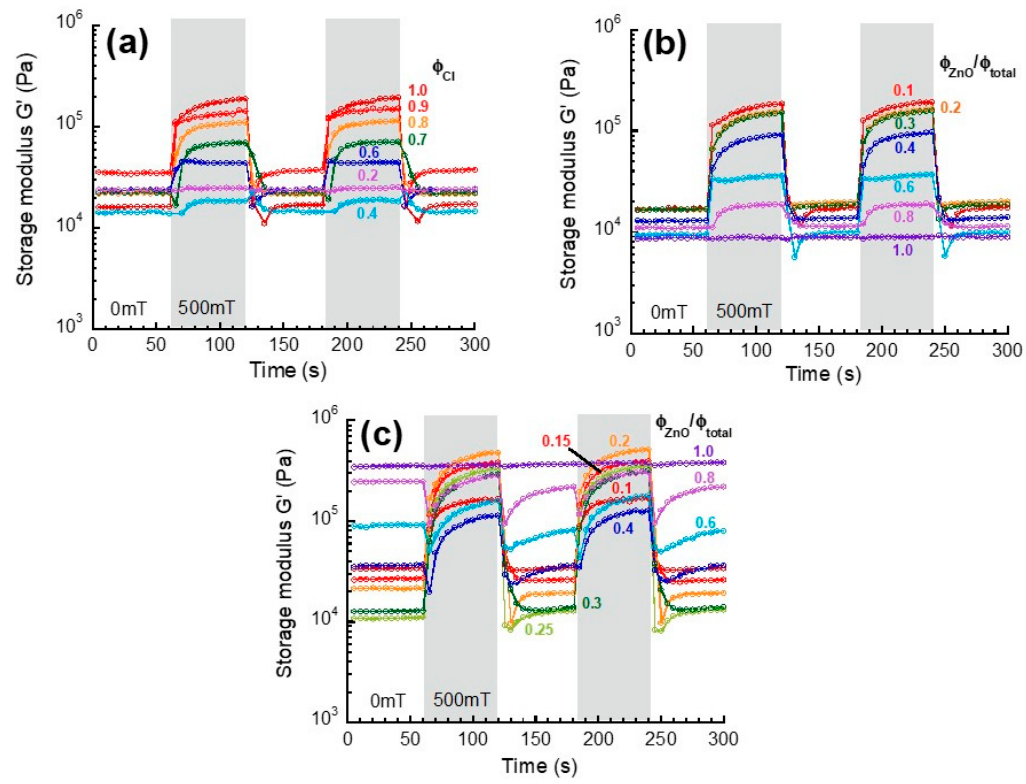
Figure 3. Magnetic-field response of storage modulus in the linear viscoelastic regime for ( a ) monomodal magnetic elastomer and bimodal magnetic elastomers containing ( b ) nonmagnetic particles or ( c ) nonmagnetic tetrapods (Frequency 1 Hz, Strain 10 − 4 ).